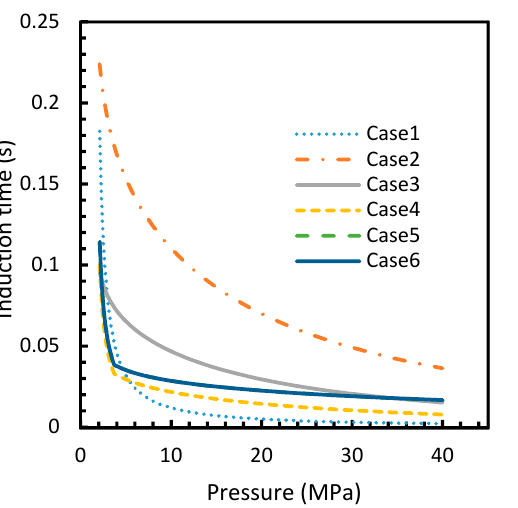
Figure 16. Profiles of CO 2 ( a ) and CH 4 ( b ) induction times, under isothermal conditions with the reference temperature of 273.2 K. The asymptotic profiles clearly show the relative rapidity of CO 2 nucleation that were reflected in the values of theoretical induction time. The point of non-differentiability obtained in the CO 2 induction time profiles, which is similar to the concentration of CO 2 profiles shown in Figure 3a.